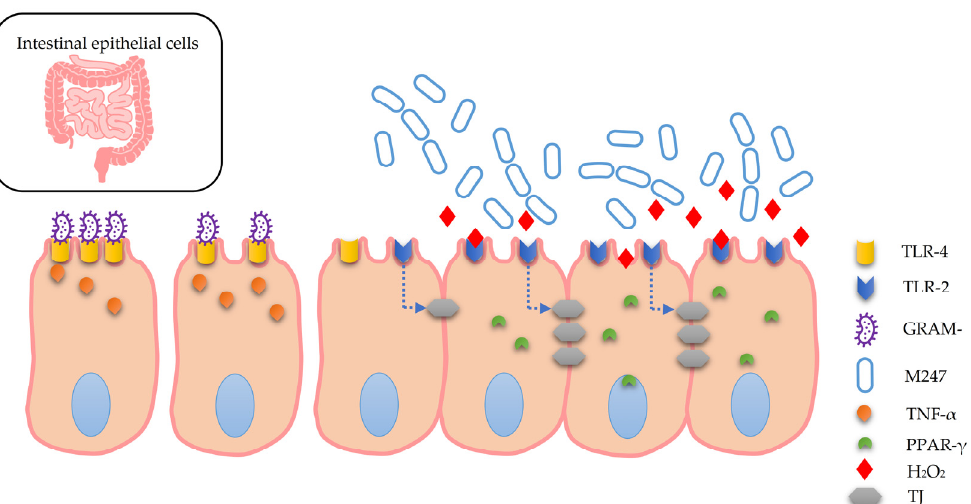
Figure 1. GRAM- bacteria can promote inflammatory dynamics with TNF- α release. Lactobacillus crispatus M247 releases hydrogen peroxide (H 2 O 2 ) that induces the upmodulation of PPAR- γ in intestinal epithelial cells. PPAR- γ causes an increase in TLR-2, and a decrease in TLR-4 and the integrity of the tight junctions (TJ). These events, on the whole, produce effects that contribute to the modulation of inflammatory processes. (see text).